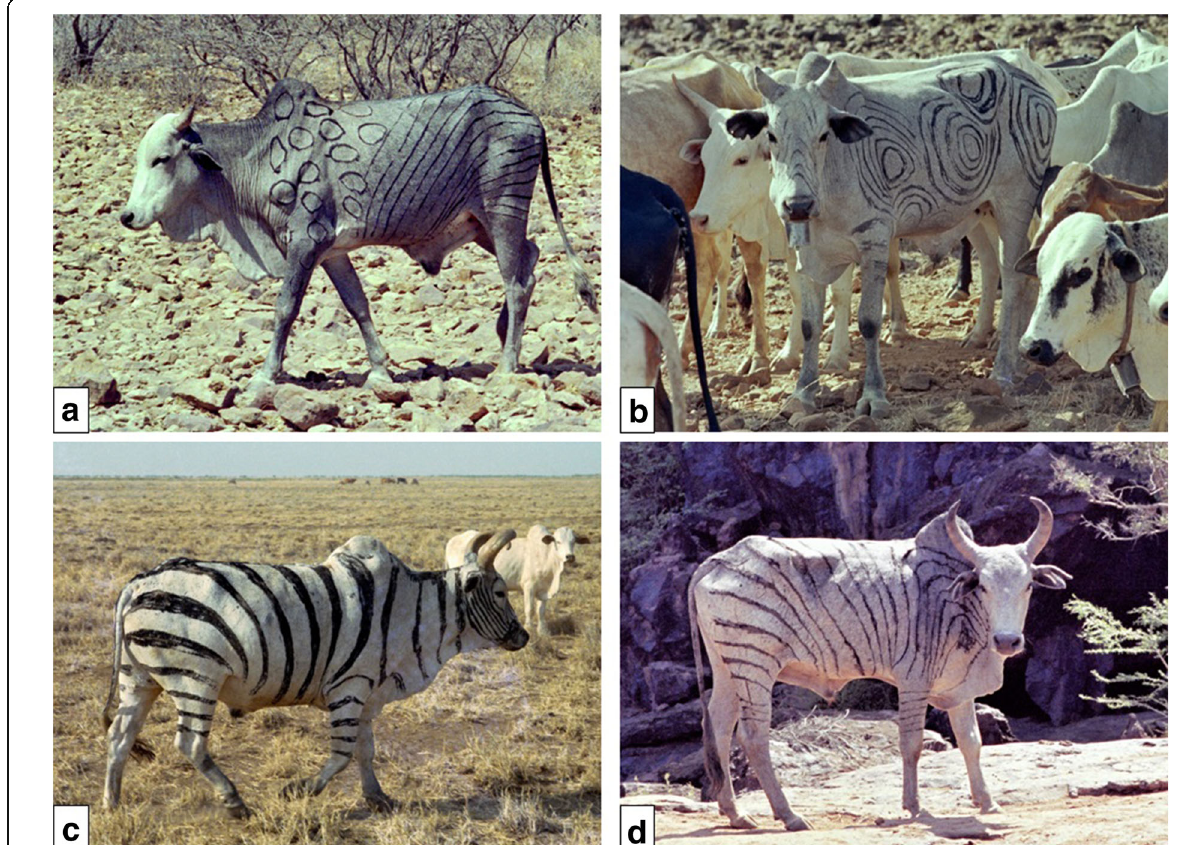
Fig. 2 Favourite-oxen of various localities in North West Turkana: a , b , d Songot Mountain, c Lotikipi